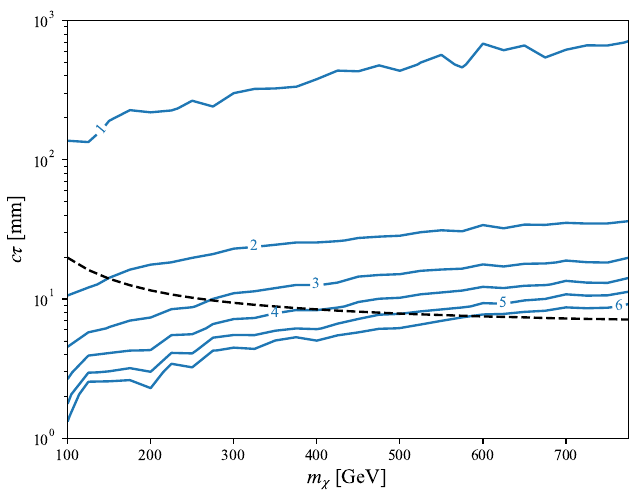
Figure 6 . Contours of signal enhancement for a 3-layer tracklet selection as compared with a conventional 4-layer selection, showing a two- to six-fold increase in the number of pure higgsinos passing the event and tracklet selection of the modified analysis in the parameter space of interest at the LHC. Contours above 6 are omitted due to inefficiencies in generation. The dashed line represents the pure higgsino decay lengths w.r.t. its